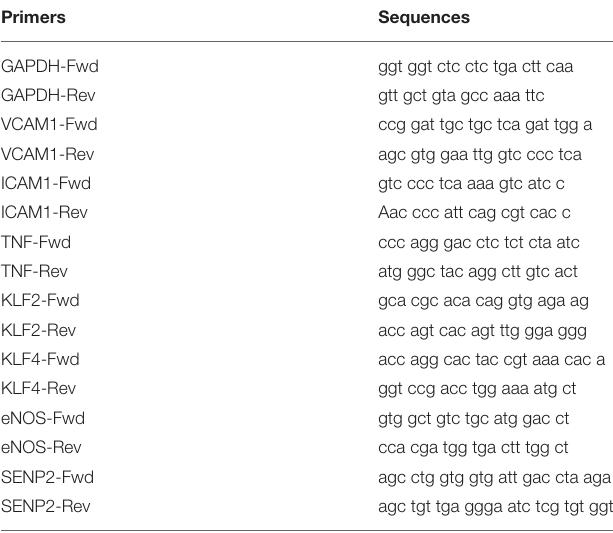
TABLE 2 | List of primers. Primers